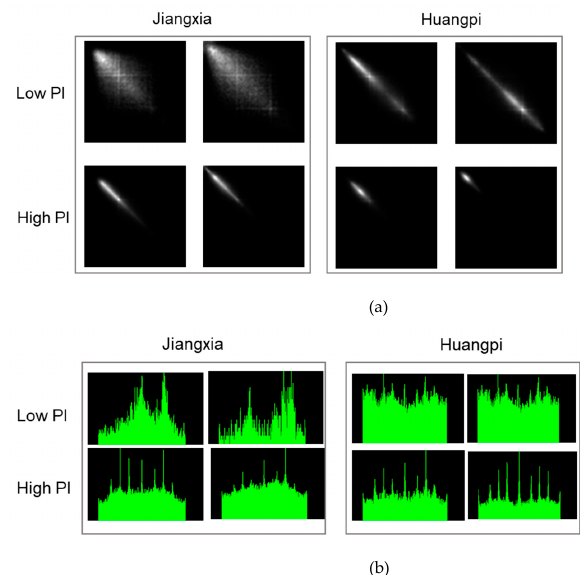
Figure 3. Examples of screenshots of some features generated by FETEX 2.0 and OpenCV: Figure 3 . Examples of screenshots of some features generated by FETEX 2.0 and OpenCV: ( a ) gray- level image representation of the GLCM; ( b ) histogram image of HOG. ( a ) gray-level image representation of the GLCM; ( b ) histogram image of